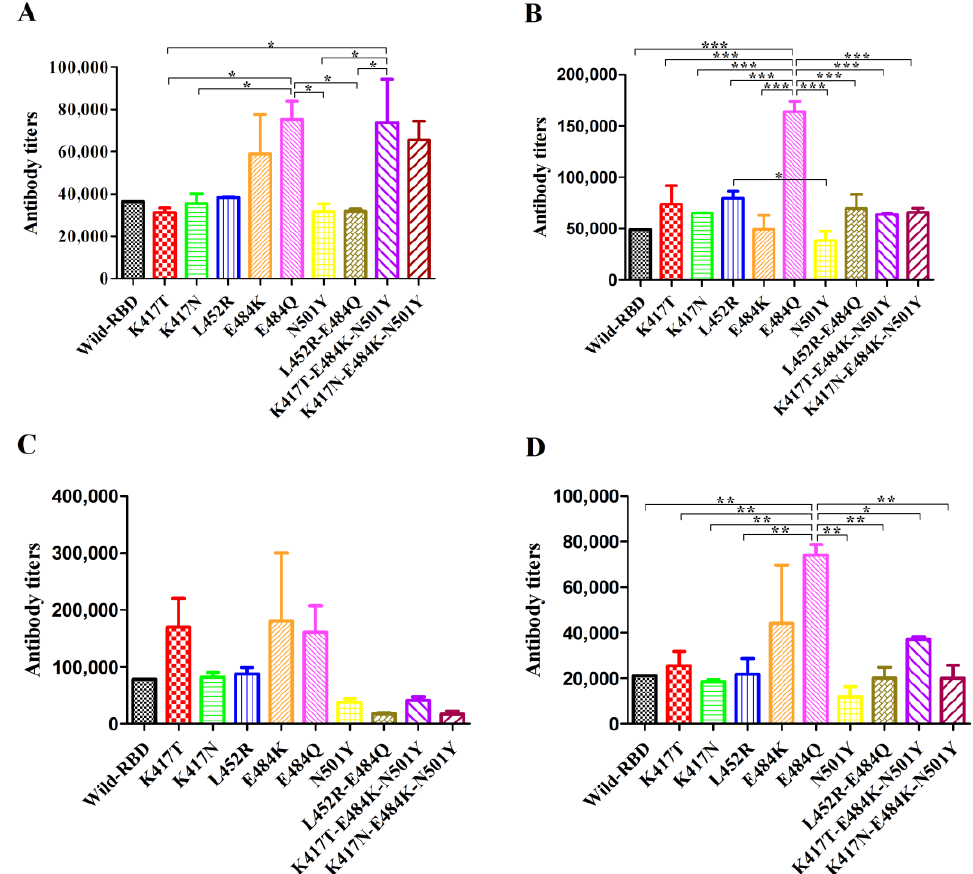
Figure 4. Extensive analysis of the antigenicity of RBD mutant protein. It was coated with 100 ng/well RBD mutant protein, and, after blocking, 2 times gradient diluted serum was added. ( A ) E484K protein. ( B ) E484Q protein. ( C ) K417T-E484K-N501Y protein. ( D ) K417N-E484K-N501Y protein. Statistical significance was defined as p < 0.05, and * p < 0.05, ** p < 0.01, *** p < 0.001.